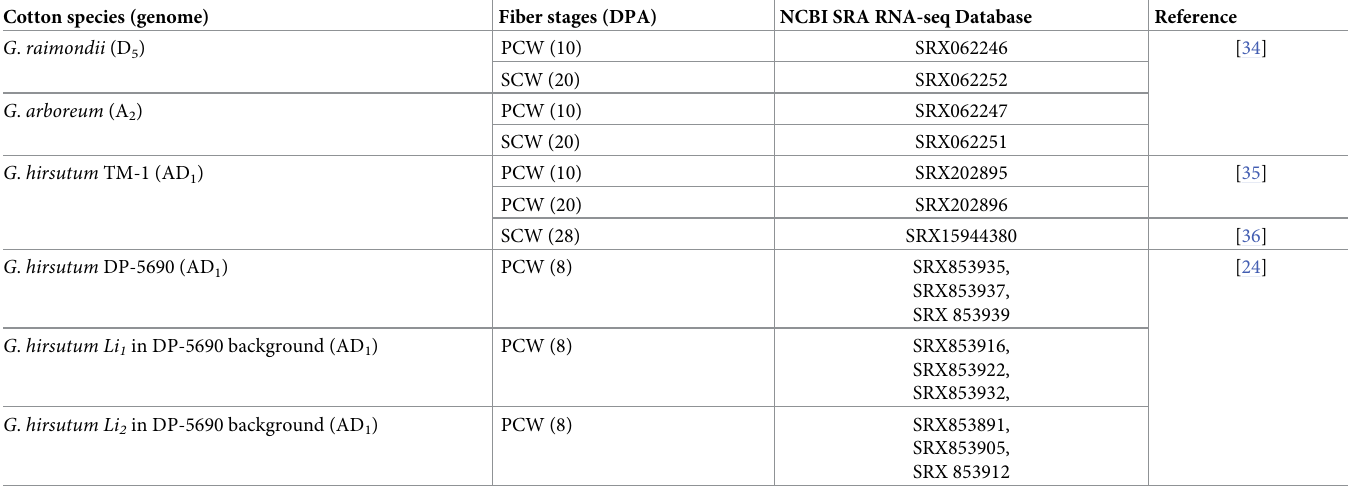
Table 1. Database of RNA-seq used in this study. Cotton species